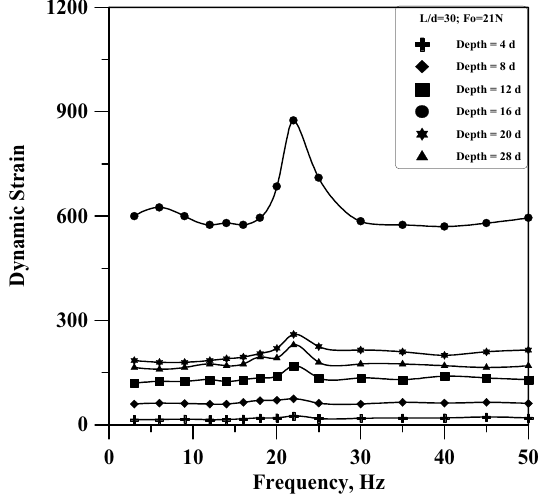
Fig. 13. Variation of dynamic strain with frequency for I c = 0.30; L/d =